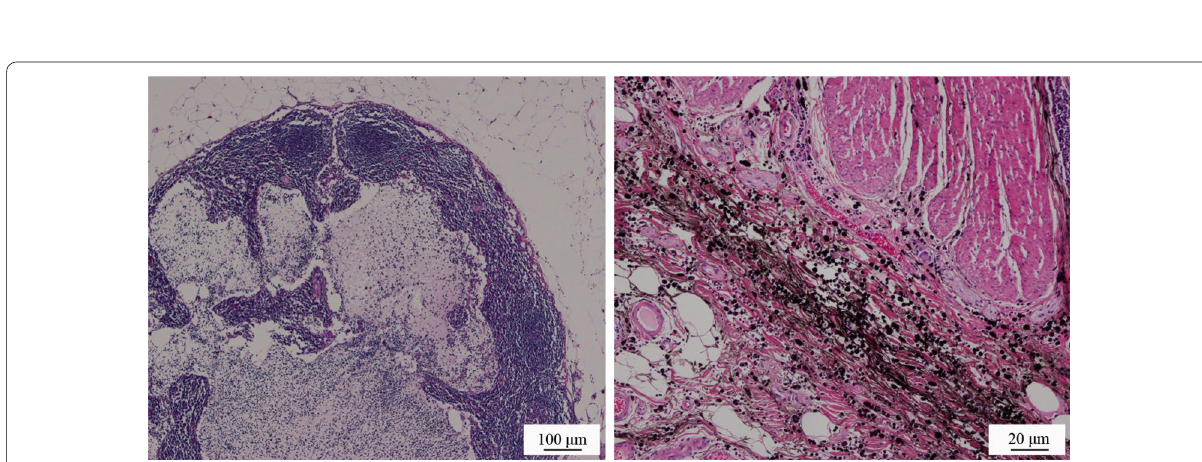
Fig. 2 Histochemical appearance of the tumor tissues from a rectal cancer patient injected with carbon nanoparticle suspension. Tumor cells could be examined clearly under microscopy after being stained by hematoxylin and eosin, indicating that the carbon nanoparticles had no effect on the histochemical observation and